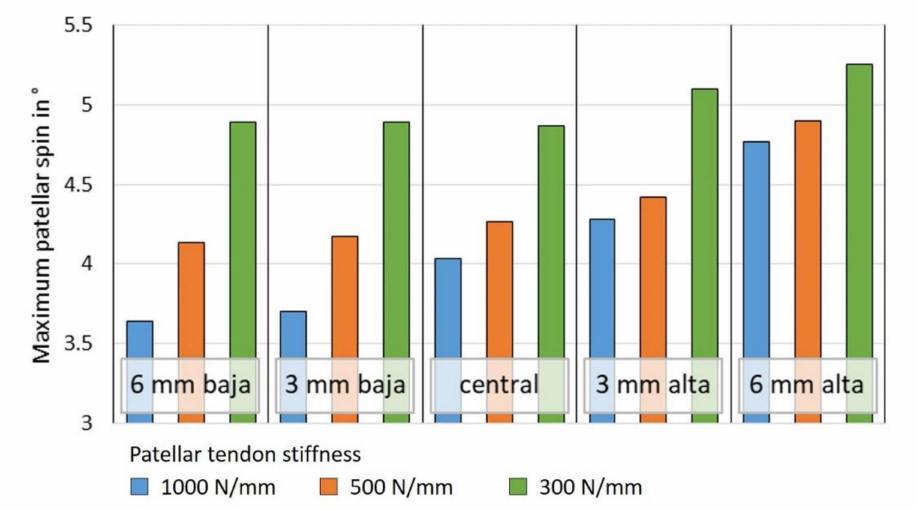
Figure 9. Peak values of the patellar spin during weight-bearing squat for several initial patellar positions (left to right: 6 mm baja to 6 mm alta) and patellar tendon stiffnesses (blue: 1000 N/mm, orange: 500 N/mm, and green: 300 N/mm). Spin is given as rotation around the floating axis between the femoral flexion axis and the patellar proximo-distal axis. A positive sign indicates a rotation to lateral